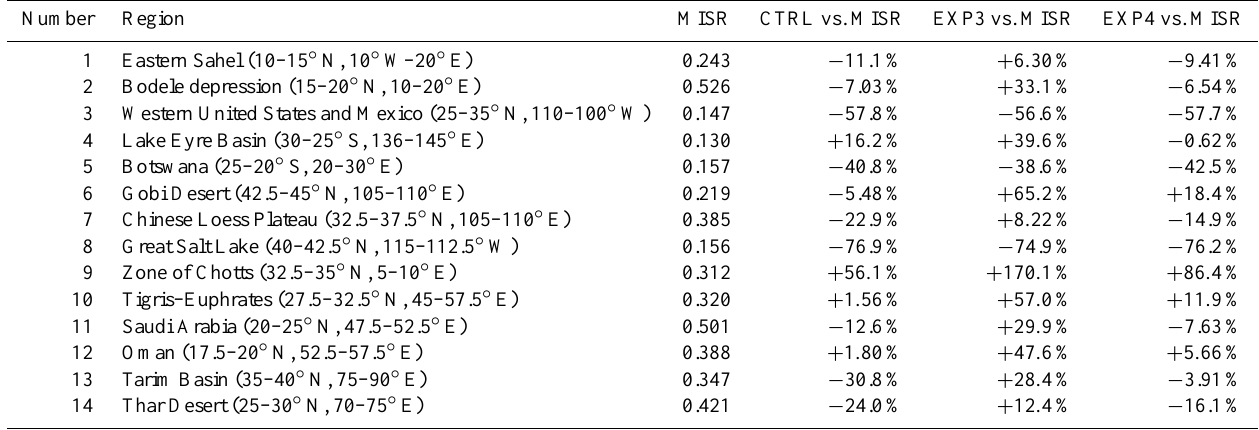
Table 4. Definition of the 14 major dust source regions in which the simulated and MISR retrieved AOD are compared in Fig. 17. The relative differences between the simulated and MISR retrieved AOD are also shown.